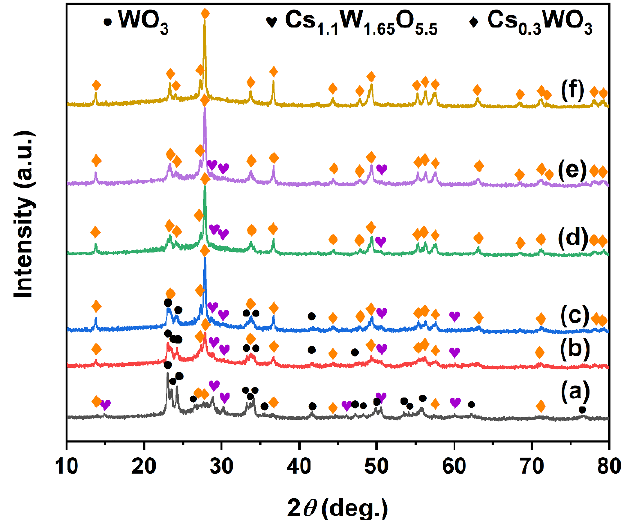
Figure 5. XRD patterns of the samples synthesized hydrothermally at 200 °C using 0.18 mmol CsCl, 0.4 mmol WO 3 , 8.8 mmol CH 3 CH 2 CHO, 2.8 mmol NH 3 · H 2 O, and 5 mmol (NH 4 ) 2 SO 4 at the time of ( a ) 4 h; ( b ) 8 h; ( c ) 12 h; ( d ) 16 h; ( e ) 20 h, and ( f ) 24 h.